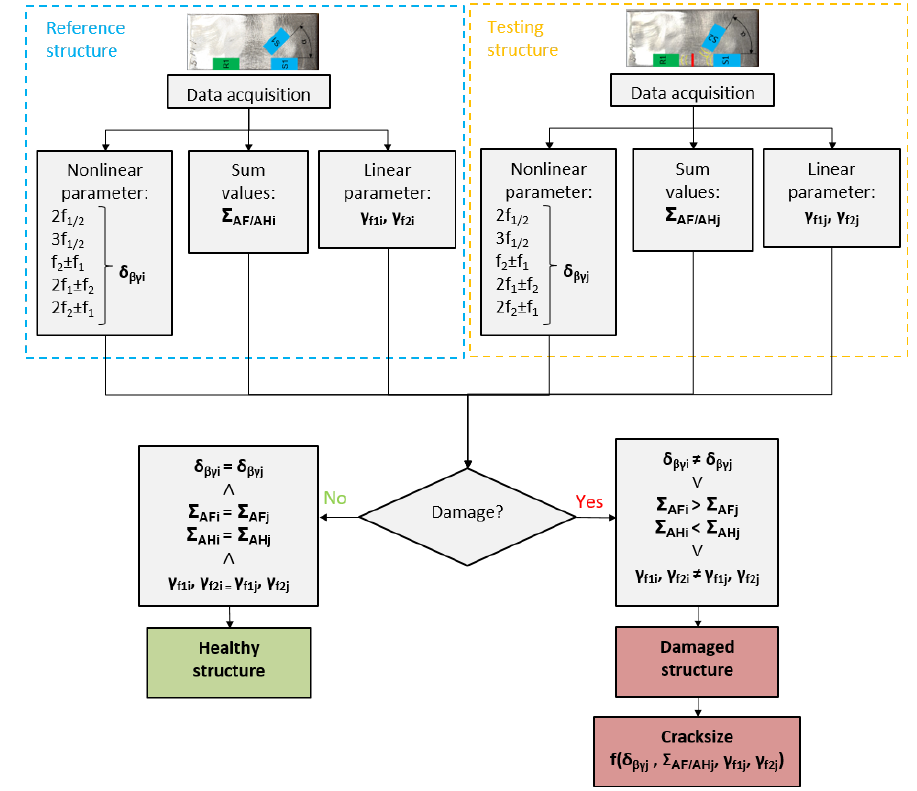
Figure 10. Damage detection methodology.